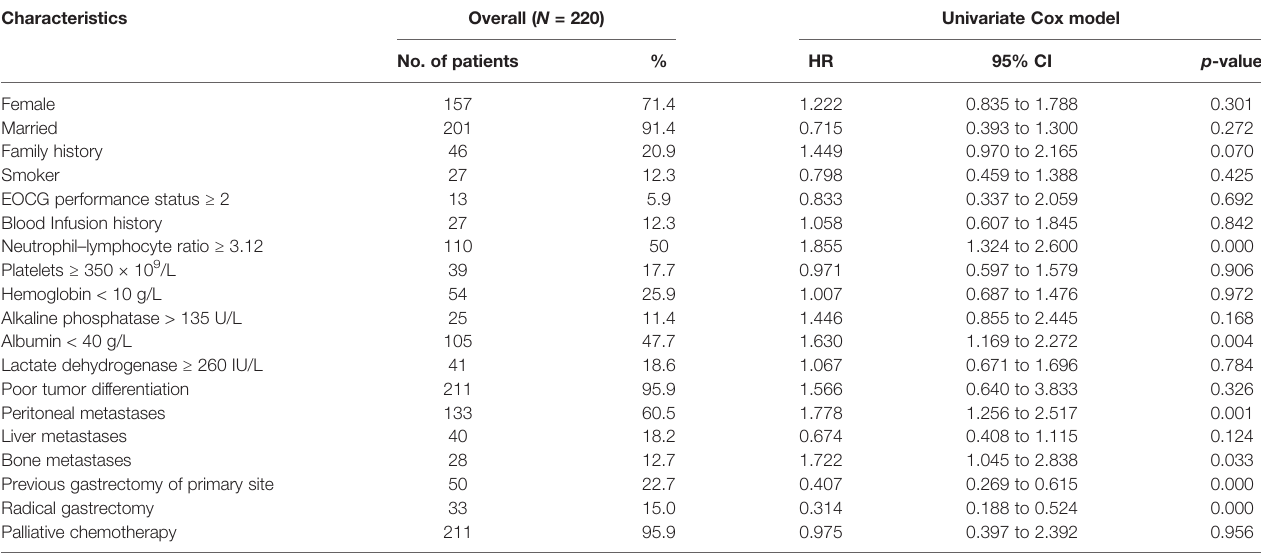
TABLE 1 | Patient characteristics and univariate analysis.